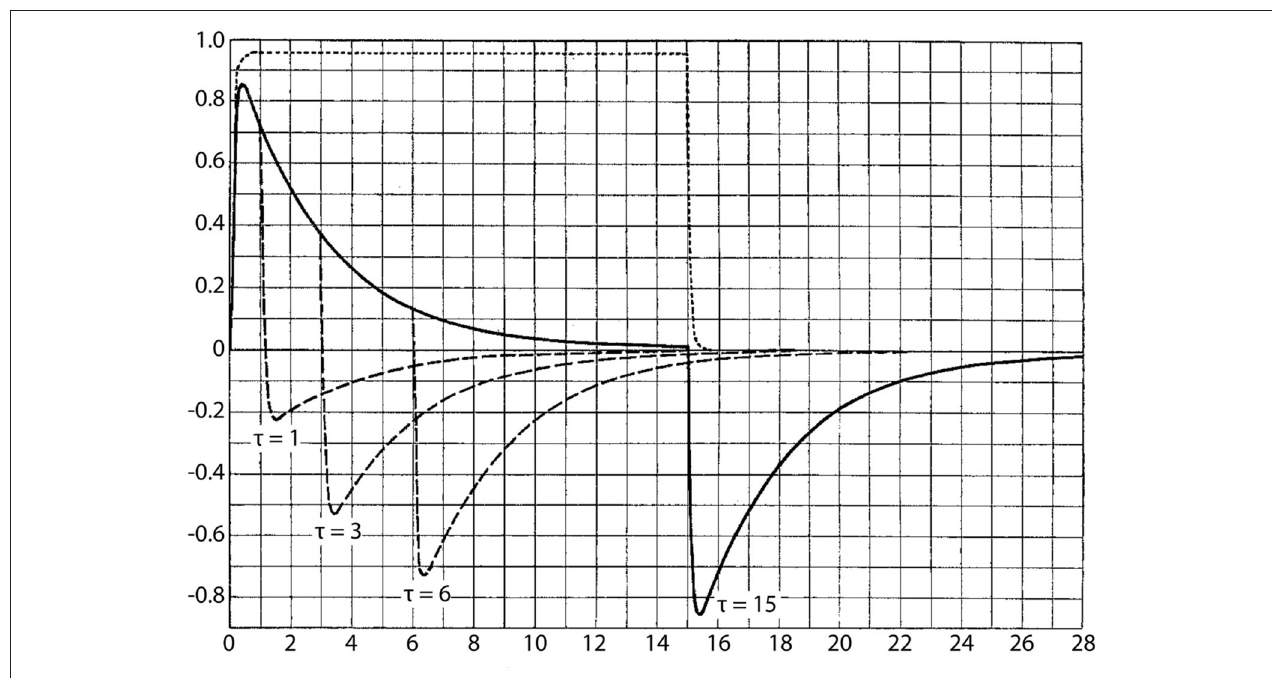
FIGURE 3 | Cupula movement during long rotation periods. Abscissa: time (scale marks 30 = 40 seconds); ordinate, cupula movement as arbitrary scale.